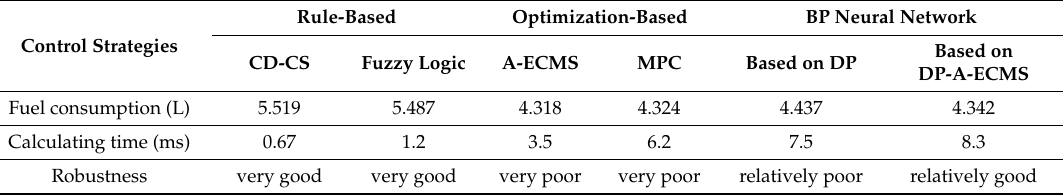
Table 4. Comparison of online control